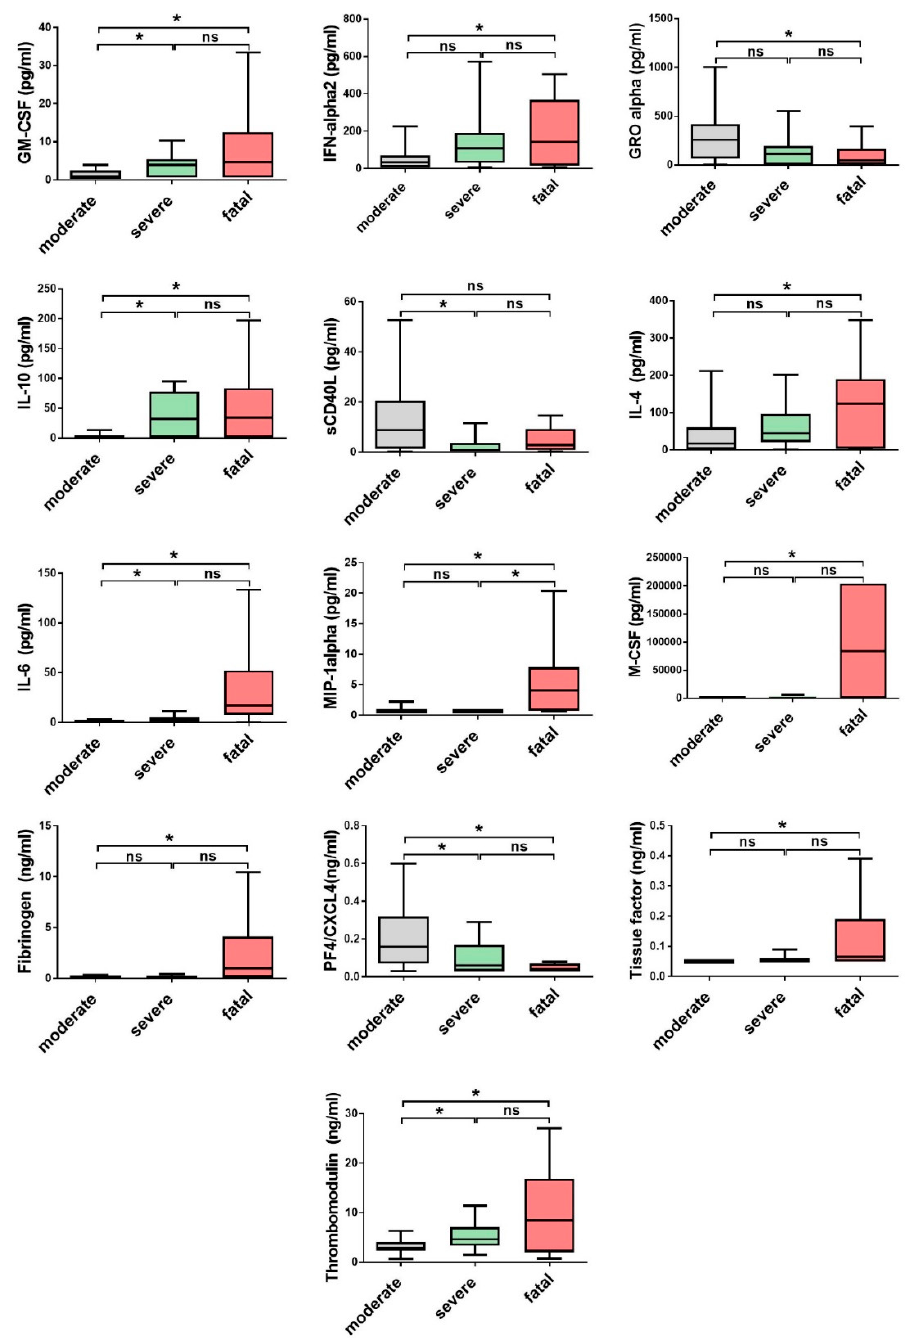
Figure 4. The cytokine and chemokine concentrations with significant di ff erences in CCHF patients, with regard to the disease progression and outcome (moderate n = 24; severe n = 18; fatal n = 14). The statistically significant di ff erences are marked with * ( p < 0.05). ns = not statistically significant. The boxes represents medians with interquartile ranges; the whiskers depict minimum and maximum values (range). Identified outliers are not included in the figures above: GM-CSF (moderate n = 3; severe n = 1), IFN- α (moderate n = 2; fatal n = 1), GRO- α (moderate n = 2; severe n = 3), IL-10 (moderate n = 4; fatal n = 1), IL-4 (moderate n = 3; severe n = 2), IL-6 (moderate n = 7; severe n = 3; fatal n = 1), MIP-1 α (moderate n = 6; severe n = 4; fatal n = 2).